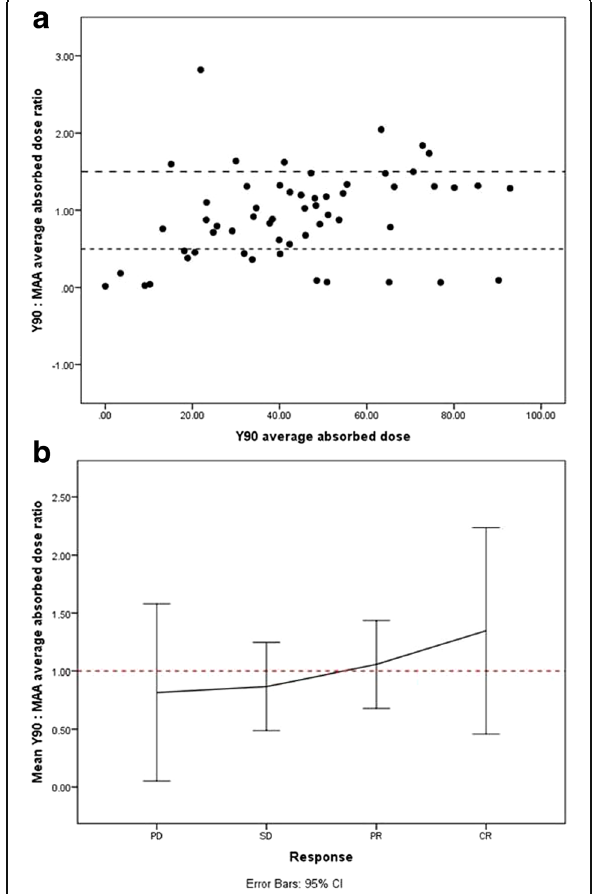
Fig. 3 a The ratio of true ( 90 Y) to predicted (MAA) mean absorbed dose across all lesions. Horizontal dashed lines represent a ±50% difference. An outlier with a ratio value of 12.3 was excluded for visual purposes. b The mean ratio of true ( 90 Y) to predicted (MAA) lesion absorbed dose for each response category. Dashed line represents a ratio of 1.0